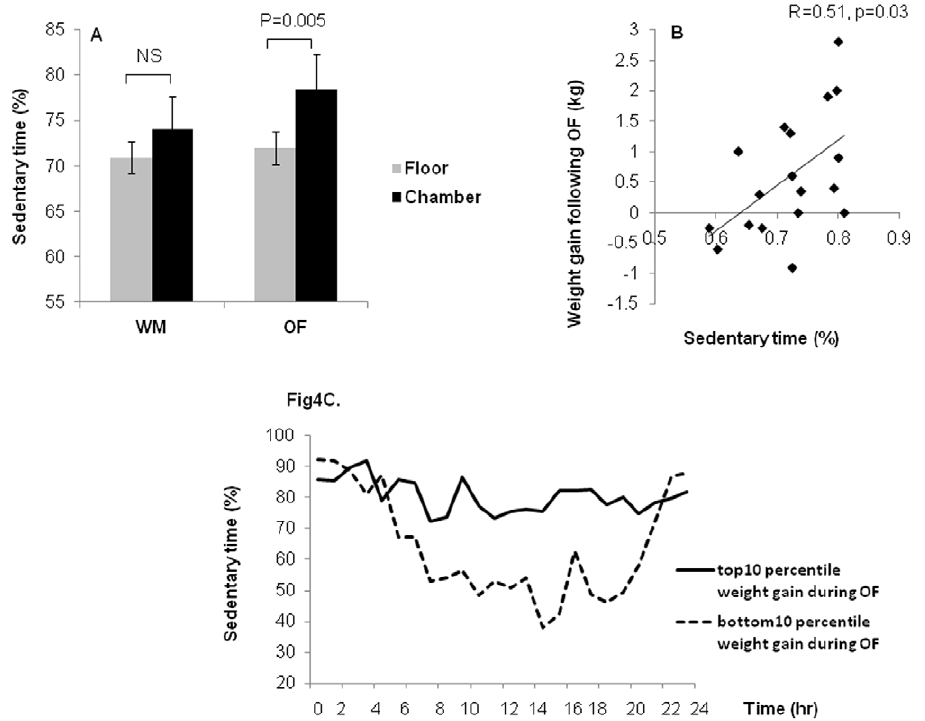
Figure 4. Comparison of sedentary time between weight maintenance diet (WM) and overfeeding diet (OF) and the correlation of sedentary time with age and weight gain during OF. Figure 4A, Sedentary time shown on the inpatient unit and in the chamber on WM (70.9 6 12.9% and 74.6 6 10.6%, respectively)and on OF (72.0 6 7.4% and 78.4 6 6.6%, respectively). Sedentary time did not differ between WM Vs. OF on the inpatient unit or in the chamber, but increased while in the chamber vs. on the inpatient unit while on OF (p=0.0005), not on WM. Figure 4B., Sedentary time was positively associated with weight gain during OF (r=0.51, p=0.03); Fig. 4C., Sedentary time shown in 24 hours in those with weight gain in top 10 and in bottom 10 percentile during OF. Time shown starting at midnight (0 on x-axis). Data shown as means 6 SD. Comparison of sedentary time between diets analyzed using paired t-test; comparison between sedentary time on inpatient unit vs. chamber analyzed using t- test. R values are Pearson